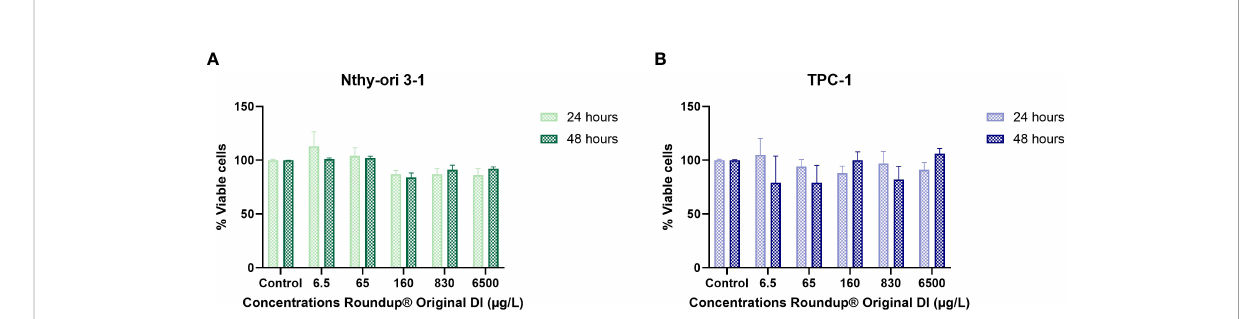
FIGURE 3 Comparison of cytotoxic effect on TPC-1 (A) and Nthy-ori 3-1 (B) strains after exposure to increasing concentrations of Roundup ® Original DI for 24 h and 48 h, measured by the CCK-8 assay and presented as mean percentage of viable cells ± SE.